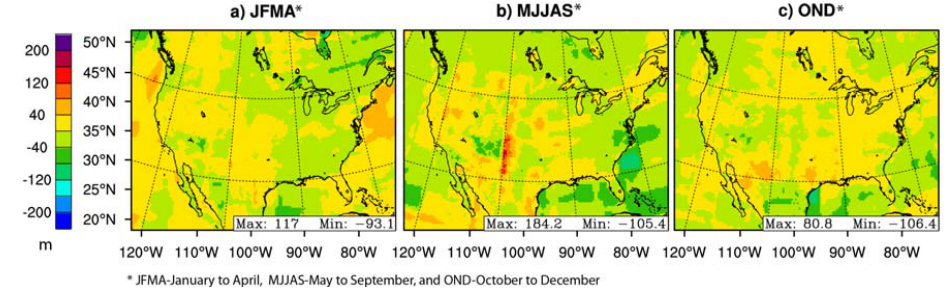
Fig. 3. Average seasonal change in PBL height difference between 2049-2051 and 1999-10